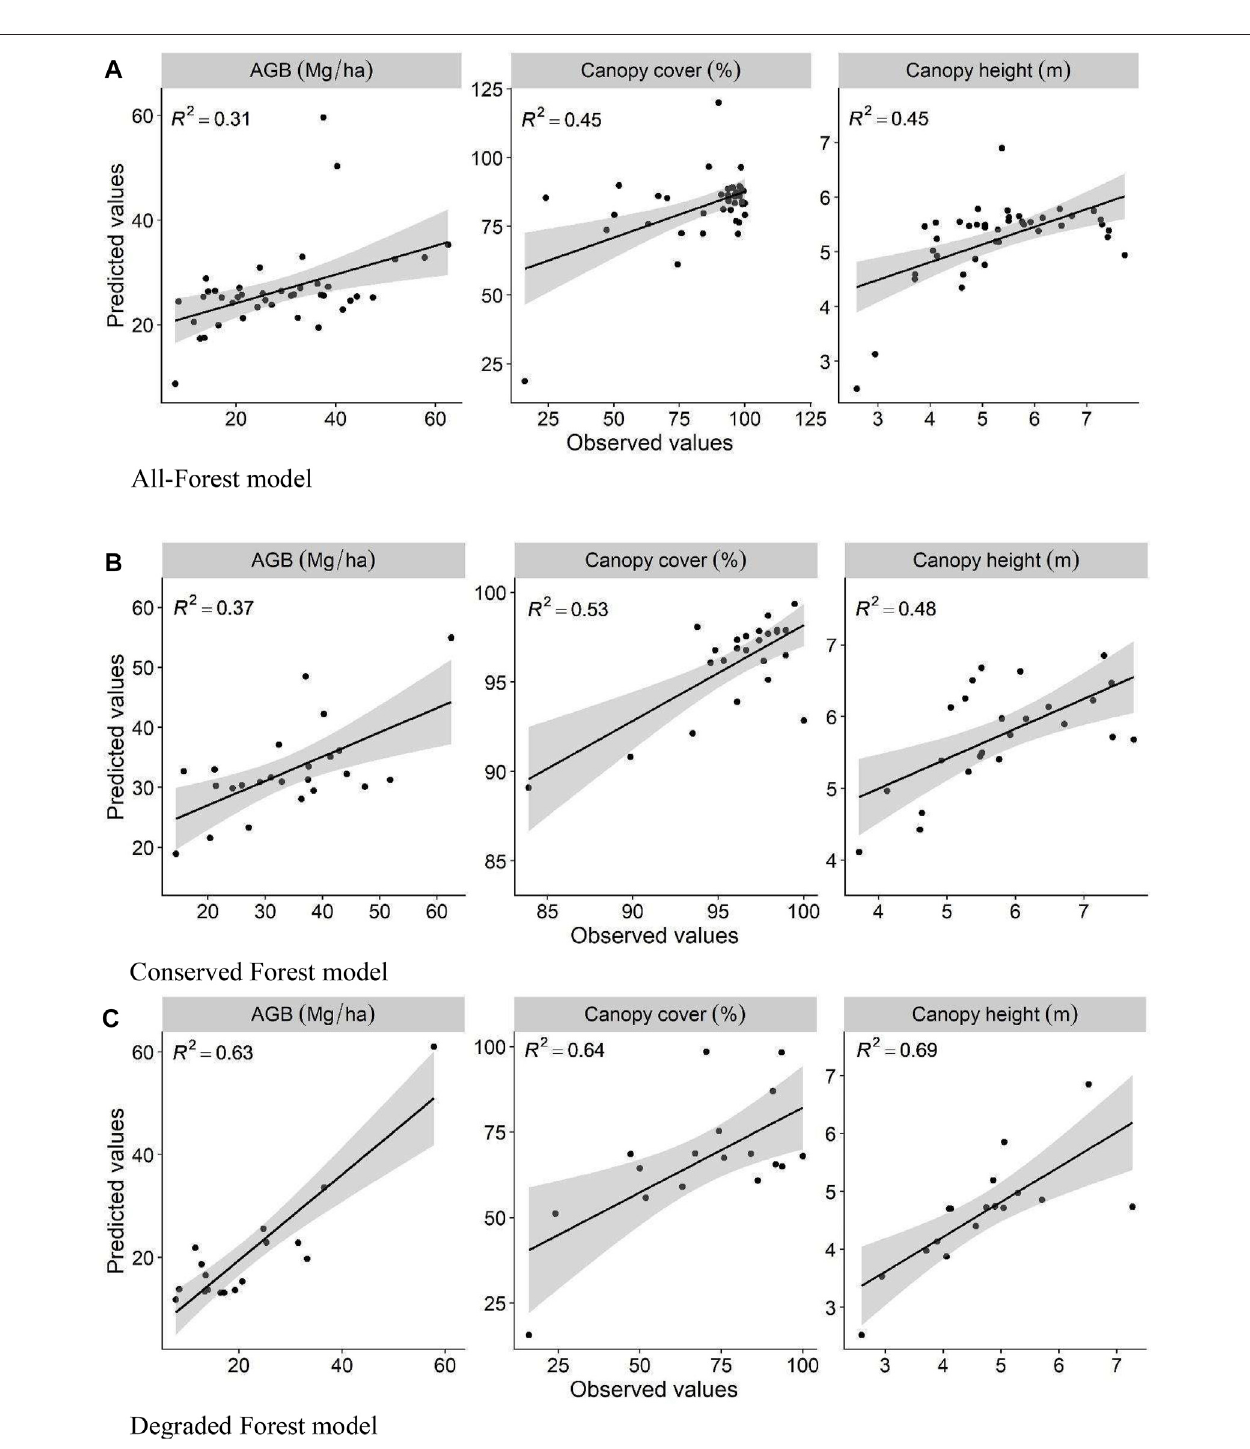
FIGURE3| Predictedvs.observedforestattributeswiththebestmodelsofdifferentdatasets.Thegrayareasshowthecon fi denceintervals. (A) :all-forestdataset; (B) : conserved forest dataset; (C) : degraded forest dataset.